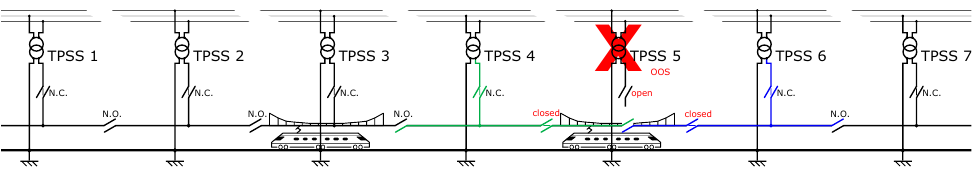
Figure 13. Connections of substations #4, #5 and #6 in a degraded